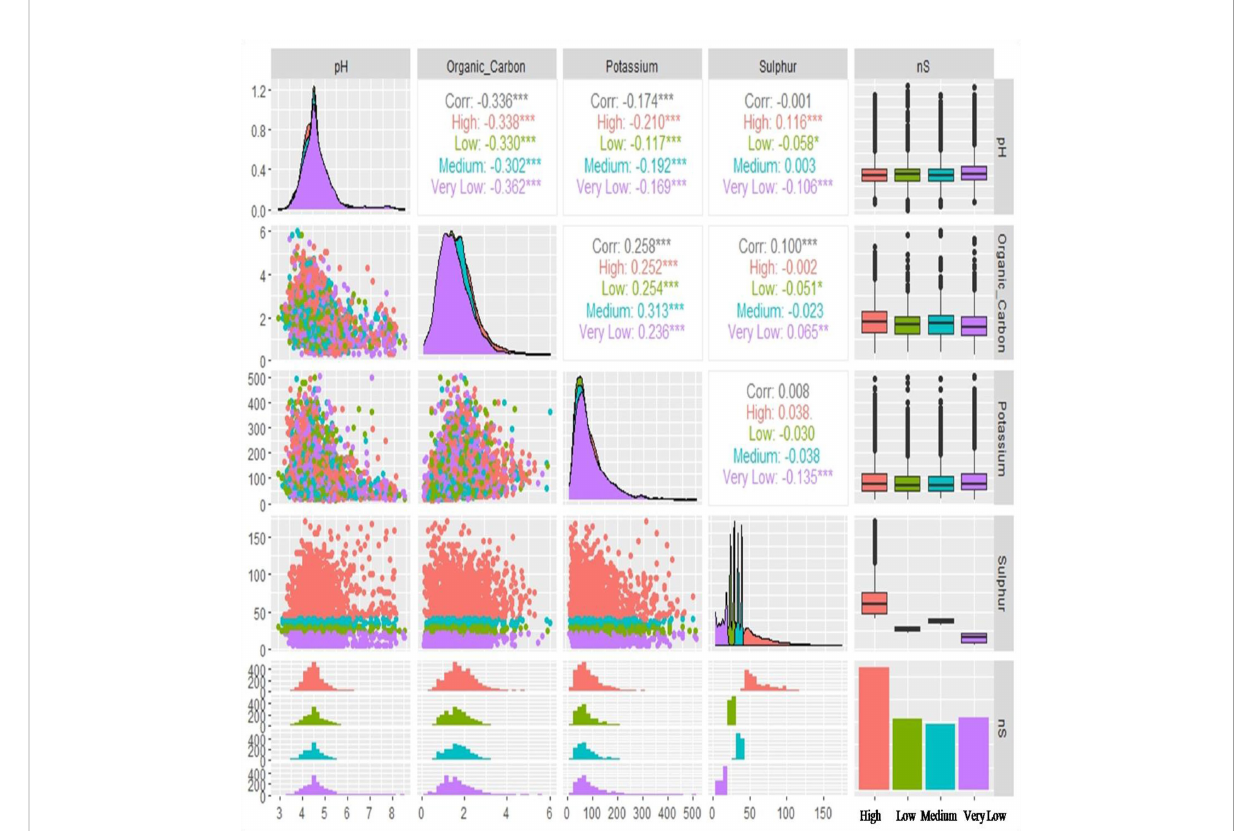
FIGURE 7 Bivariate correlations of reported soil parameters (pH, organic carbon, available potassium and available sulphur) of 7300 analyzed soil samples against different categories of soil available sulphur (AS) represented by box plot, density, scatter, histogram and bar diagram: here ’ abbreviated as ‘ AK ’ in the manuscript and Sulphur is ‘ available sulphur ’ ‘ Organic_Carbon ’ is ‘ OC ’ , Potassium is ‘ available potassium (K) as K 2 O abbreviated as ‘ AS ’ in the manuscript; Signi fi cance codes: “ *** ” at 0.001%, “ ** ” at 0.01% and “ * ” at 0.05%